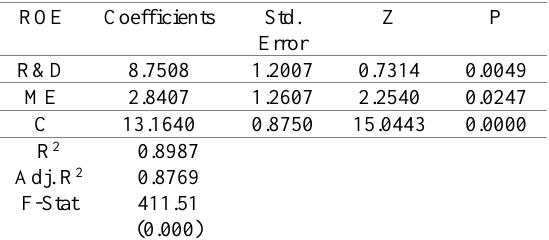
Table 17. Panel ARDL MG-CCE test results of Model